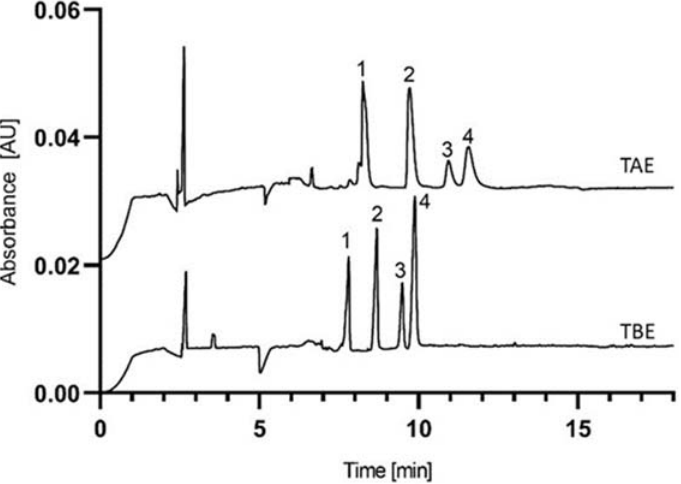
Figure 1. Capillary SDS agarose gel electrophoresis separation of the omalizumab subunits in Tris– acetate–EDTA (TAE, upper trace) and Tris–borate–EDTA (TBE, lower trace) background electrolytes. Peaks: 1–10 kDa internal standard; 2–LC; 3–ngHC; 4–HC. Conditions: bare fused silica capillary (20 cm effective length, 30 cm total length, 50 μ m i.d.); UV detection at 214 nm; E = 500 V/cm in reversed polarity (cathode at the injection side); Separation temperature: 25 °C; Electrokinetic injection: 5 kV for 10 s.